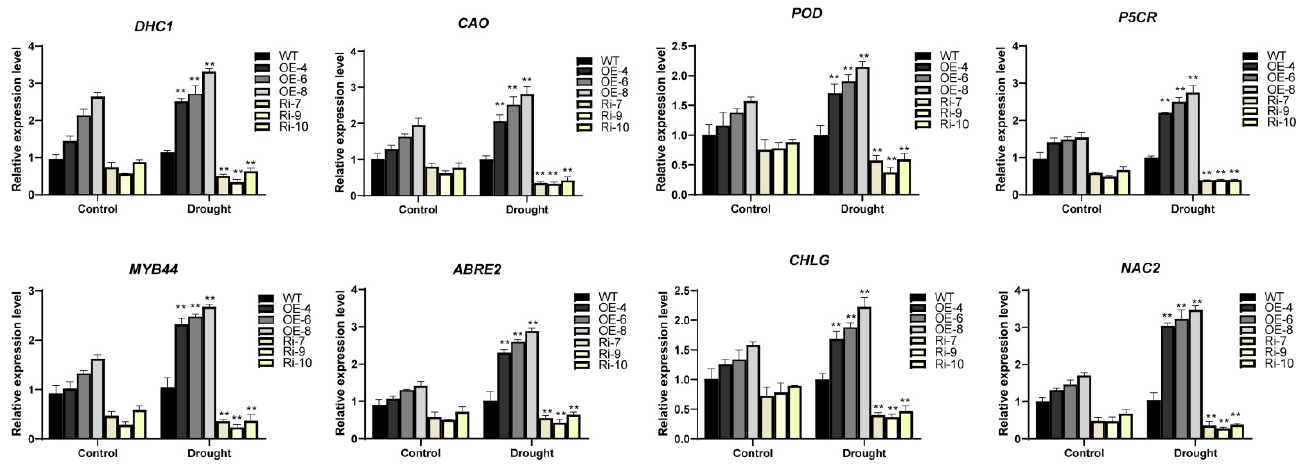
Figure 8. Quantitative analysis of the stress-related genes ( CAO , CHLG , POD , P5CR , NAC2 , MYB44 , and ABRE2 ) in different lines (data represent the means ± SD of 3 replicates; Student’s t test was performed to compare differences between the wild-type and the transgenic plants under natural drought stress, along with one-way analysis of variance (ANOVA), ** p value < 0.01).